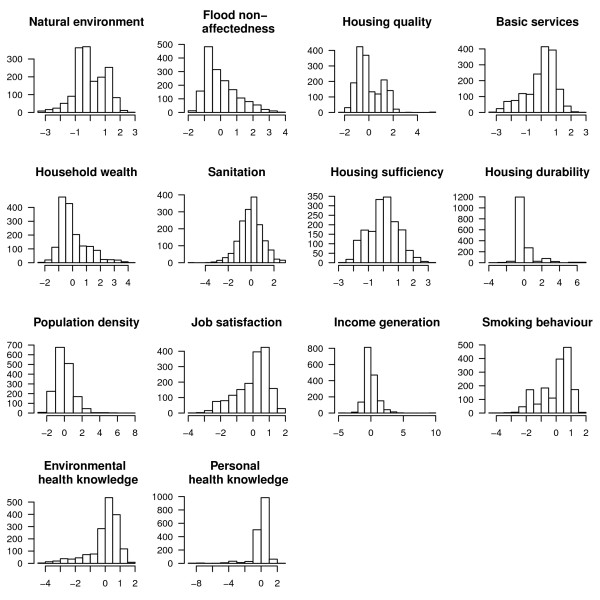
Histograms for derived factors. Descriptive statistics for the factors extracted through factor analysis in SPSS 17.